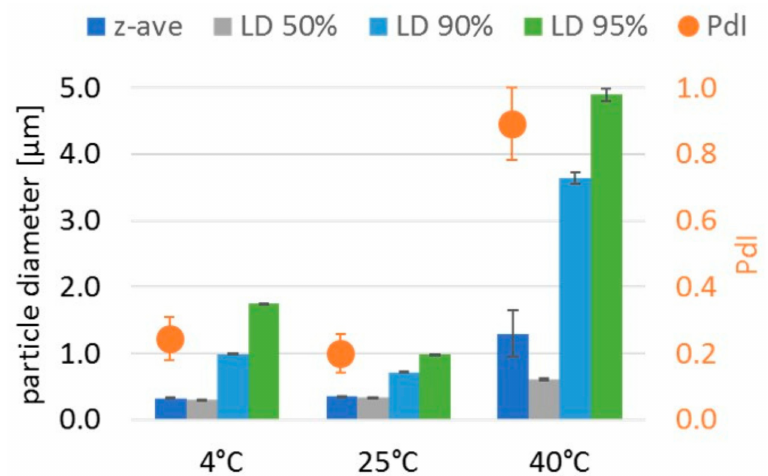
Figure 4. Particle size and polydispersity index of Symurban nanocrystals stabilized with 2% Plantacare 810 UP after 12 months of storage at 4, 25 and 40 ◦ C. Best stability was achieved at 25 ◦ C followed by 4 ◦ C. Under stress conditions of 40 ◦ C, aggregation